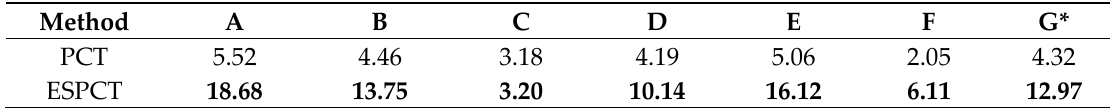
Figure 4. PCT (upper) and ESPCT (lower) loading images corresponding to PC1-PC4. Table 1. SNR values of PCT and